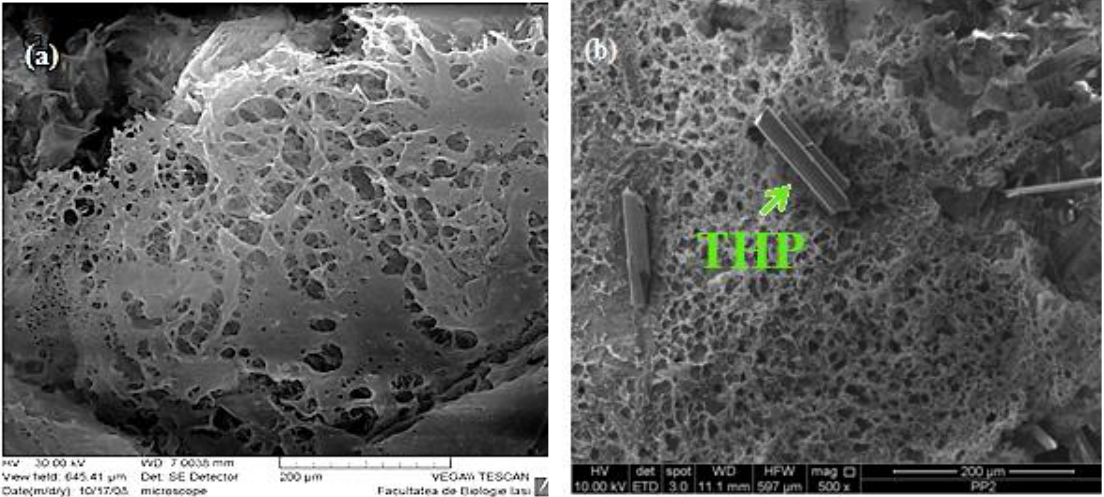
Figure 3. Scanning electron microscope (SEM) images of IPC 72/28 unloaded ( a ) and loaded with theophylline ( b ) and grafted copolymer AgA- g -PNIPAAm unloaded ( c ) and loaded with theophylline ( d ). SEM images confirmed the NIR-CI results regarding the uniform distribution of theophylline within the polymer matrices. 3.3. TGA Results